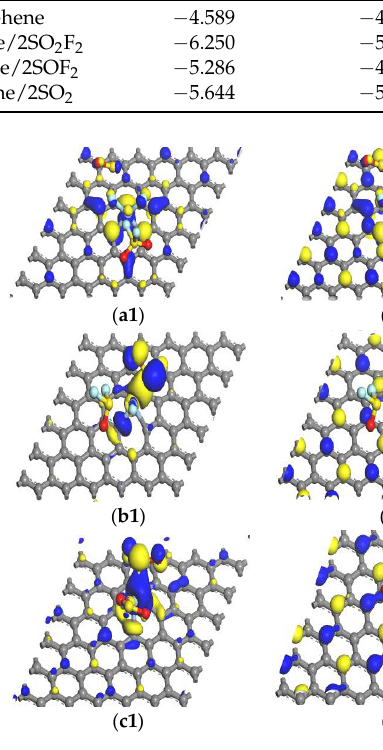
Figure 10. HOMO and LUMO: ( a1 , a2 ) double SO 2 F 2 ; ( b1 , b2 ) double SOF 2 ; ( c1 , c2 ) double SO 2 .